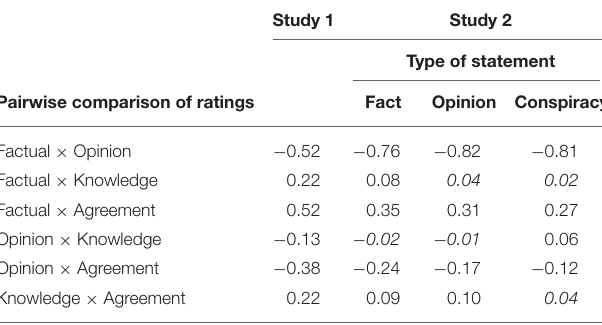
TABLE 1 | Pearson’s correlation coefficients for Studies 1 and